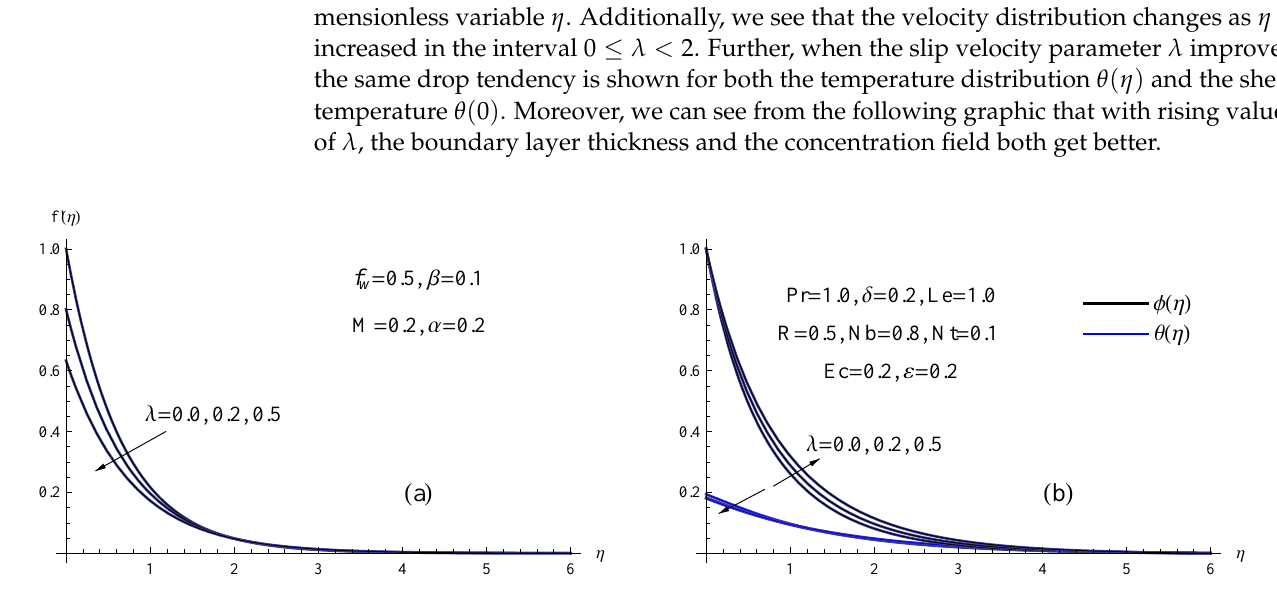
Figure 6. ( a ) The f (cid:48) ( η ) for chosen λ , ( b ) θ ( η ) and φ ( η ) for chosen λ . According to the influence of the Eckert number Ec , the temperature distribution θ ( η ) shows modification in Figure 7a. In the nanofluid heat transfer mechanism, the principal objective of the viscous dissipation phenomena is to alter the thermal performance with sources of energy. Larger Eckert number values indicate that heat is dissipating and traveling in the direction of the fluid as a result of viscous force. Fluid particles travel quickly as a result, causing more collisions between them. This greater collision produces thermal energy by converting kinetic energy. Furthermore, the graph of the temperature field θ ( η ) for miscellaneous values of thermal radiation parameter R is designed in Figure 7b. With the higher thermal radiation parameter along the sheet, as opposed to away from it, a significant drop in both the sheet temperature θ ( 0 ) and the nanofluid temperature is seen.